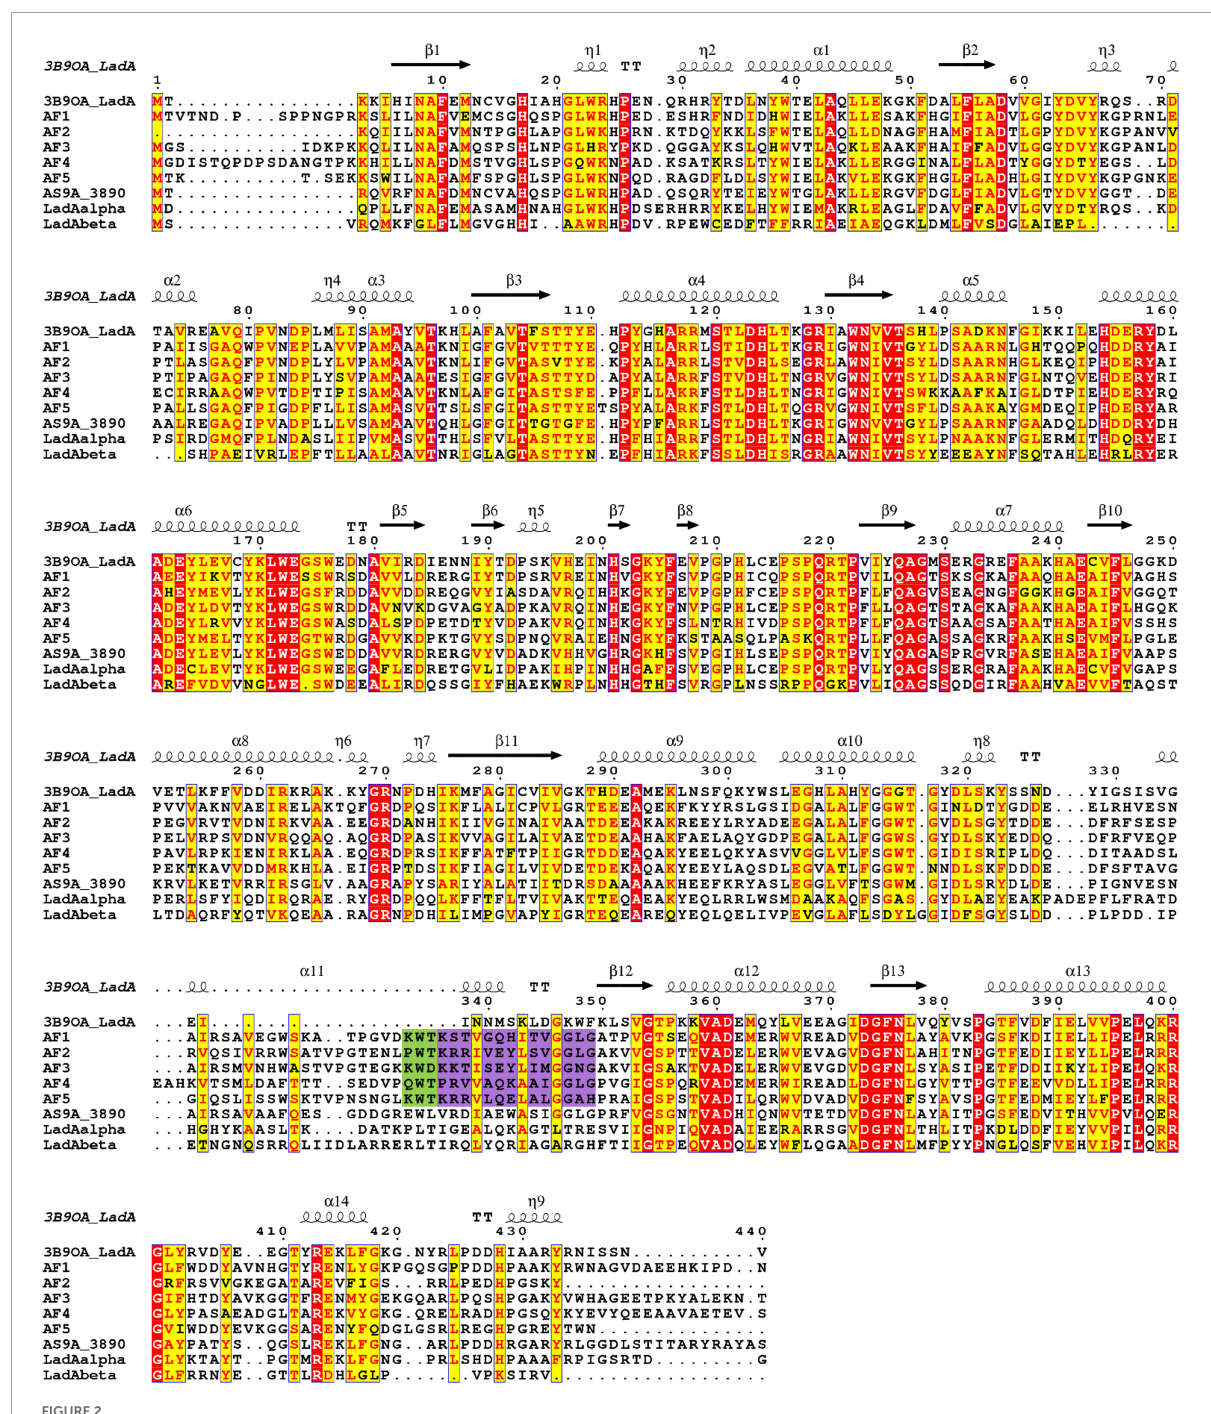
FIGURE2 Multiple sequence alignment of putative homologs of Aspergillus flavus NRRL 3357 ( Af1 , Af2 , Af3 , Af4 , and Af5 ) comparison to G. thermodenitrificans NG80-2 LadA (Li et al., 2008) (3B9O_A), functional homologs from G. thermoleovorans B23 (Boonmak et al., 2014) (LadA α B23 , LadA β B23 ), and Amycolicicoccus subflavus (Nie et al., 2013) (AS9A_3890). Identical residues are indicated in red, and the most conserved residues are highlighted in yellow. The secondary structure of LadA (3B9O_A) is indicated above the sequence alignment. The purple highlight indicates the additional region in A. flavus homologs compared to LadA (3B9O_A). Conserved substrate-binding residues upstream of the additional region in A. flavus homologs are highlighted in green. Alignment graphic was generated using ENDscript server (Robert and Gouet,